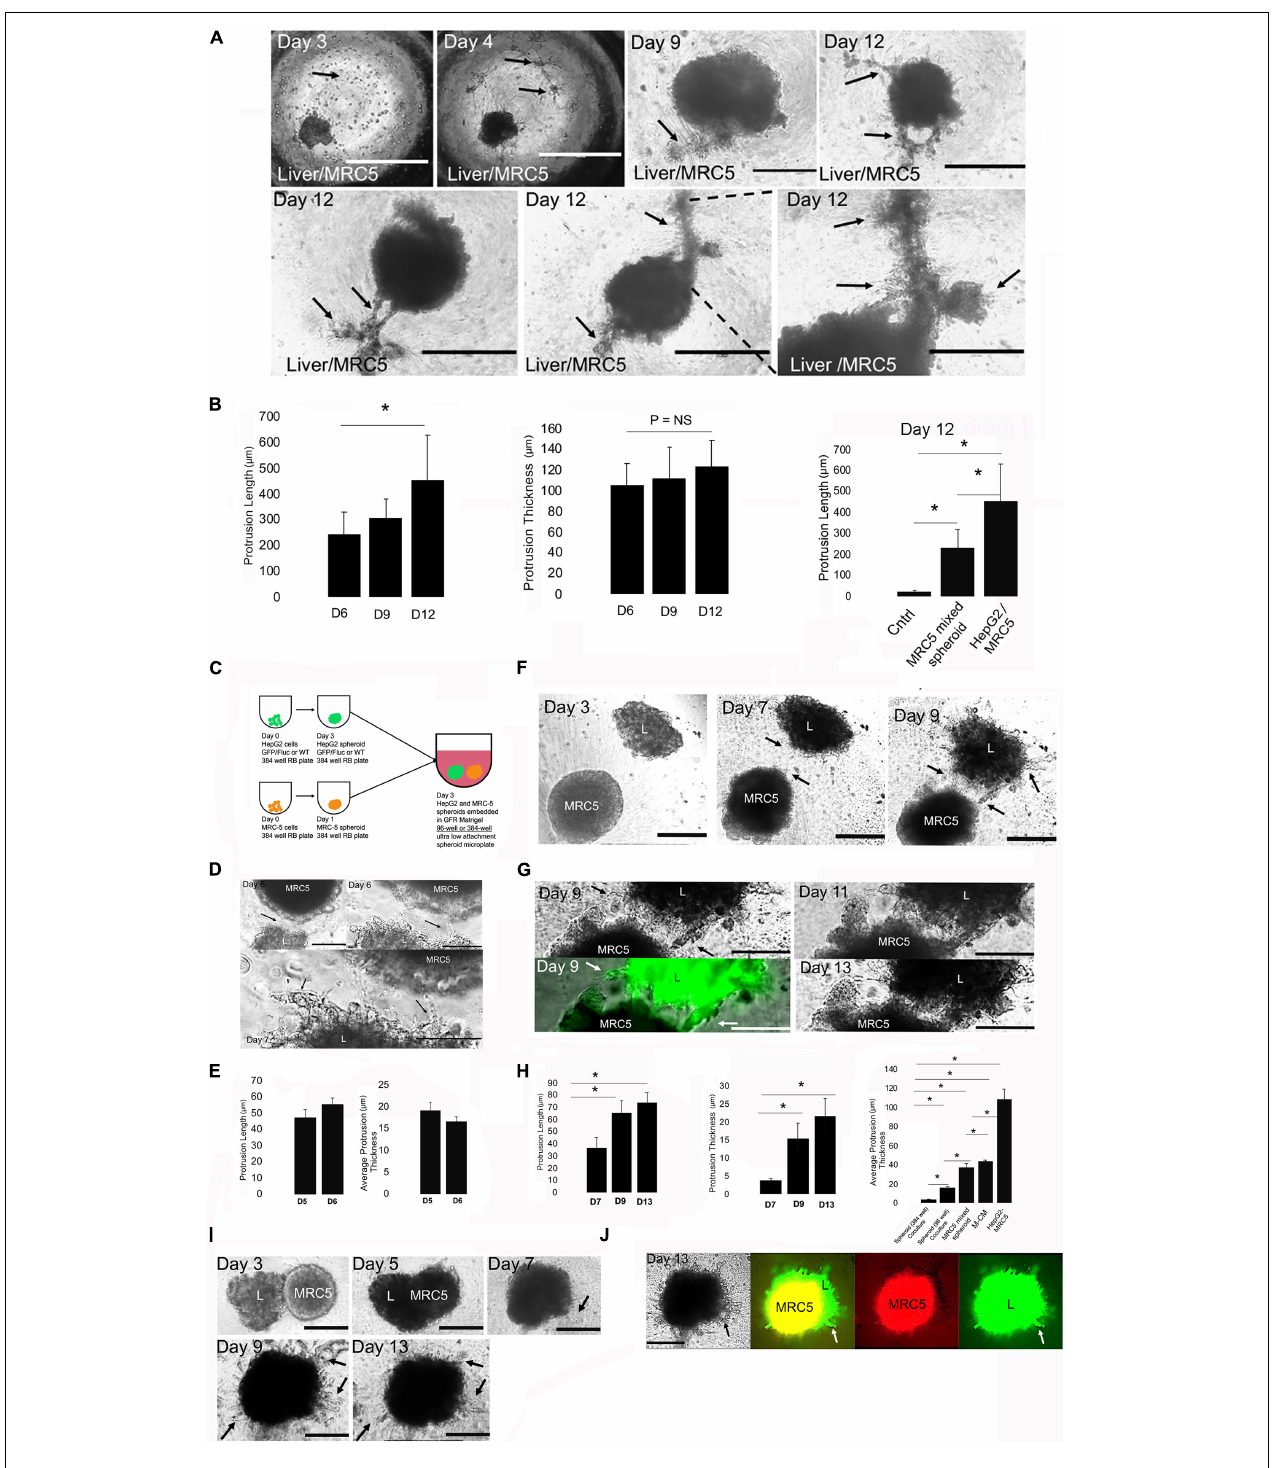
FIGURE 5 | Engineering fibroblast density and format for increased 3D collective cell migration. (A) Phase-contrast microscopy images of HepG2 spheroids cultured in MG bearing high density (30,000 cells) of MRC-5 cells. Top row, left to right: days 3, 4, 9, and 12. Day 3: MRC-5 cells initially after seeding (arrow). Bar = 1,000 µ m. Day 4: MRC-5 cells spreading and interconnecting (arrows). Bar = 1,000 µ m. Day 9: Thick hepatic cord (arrows). Bar = 400 µ m. Day 12: multiple, thick hepatic cords. Bar = 400 µ m. Bottom row, left to right: each image in a separate experimental replicate on day 12 demonstrating thick hepatic cord formation (arrows). Bar = 400 µ m. (B) Bar graph analysis of HepG2 spheroids cultured in MG bearing high density (30,000 cells) of MRC-5 cells. Left to right, left: protrusion length on days 6, 9, and 12 shown, days 9 and 12 compared, P = 0.05, n = 3. Middle: protrusion thickness on days 6, 9, and 12 shown, days 9 and 12 compared, P = NS, n = 3. Right: bar graph analysis comparing protrusion length between control (HepG2 spheroid in MG), HepG2 and MRC-5-mixed spheroid, and HepG2 with high-density MRC-5 in the MG. Control ( n = 3) compared with HepG2 with MRC-5 in MG ( n = 3), P = 0.00053, and with MRC-5-mixed spheroid ( n =